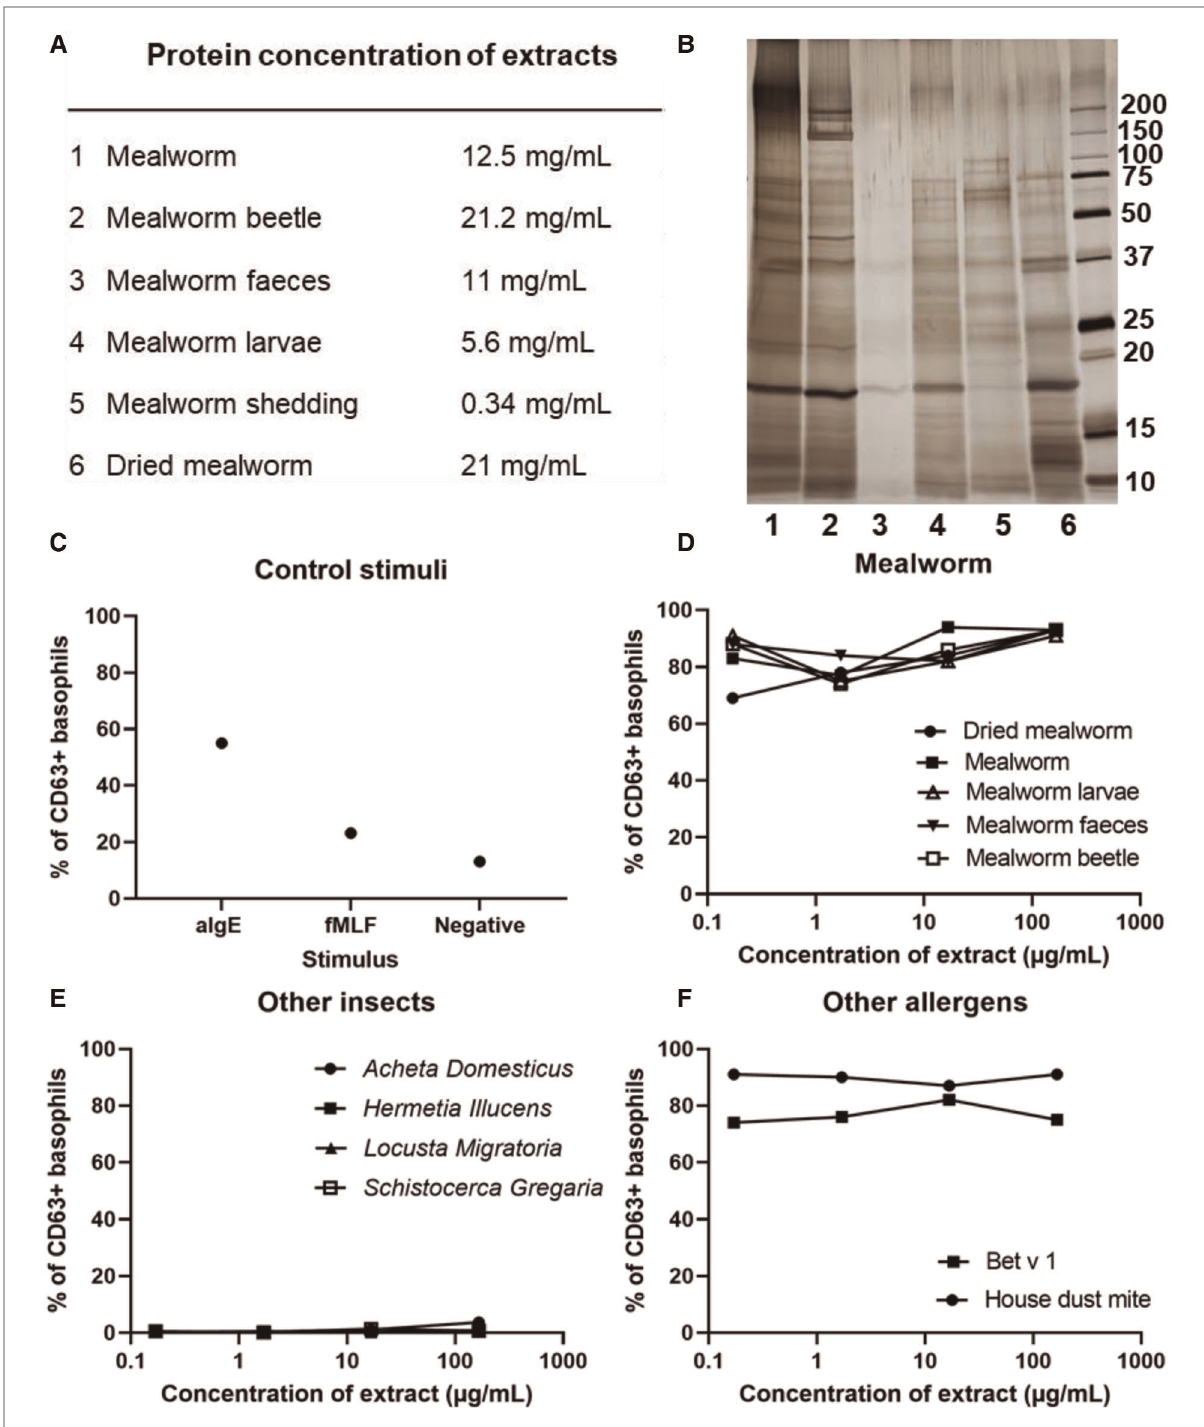
FIGURE 1 Con fi rmation of mealworm allergy by Basophil activation tests. ( A ) Protein concentrations of in-house generated mealworm extracts, measured by BCA. ( B ) SDS-page/silver stain of mealworm extracts, 5 µg of each extract loaded. x-axis in panels ( D – F ): Log-transformed protein concentration range of different extracts used, Y-axis in panels C – F : % of CD63+ basophils i.e. % degranulated basophils. ( C ) Positive controls: aIgE: anti-IgE antibody, fMLF: N-formyl-methionine-leucyl-phenylalanine; Negative control: basophil stimulation buffer. ( D ) Different extracts derived from mealworm, ( E ) insect extracts, and ( F ) Bet v 1 and house dust mite